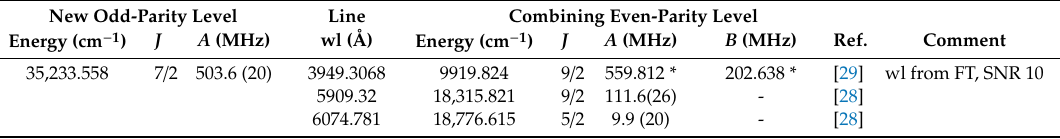
Table 3. Properties of the new odd-parity level and classified lines. Uncertainty of the energy of